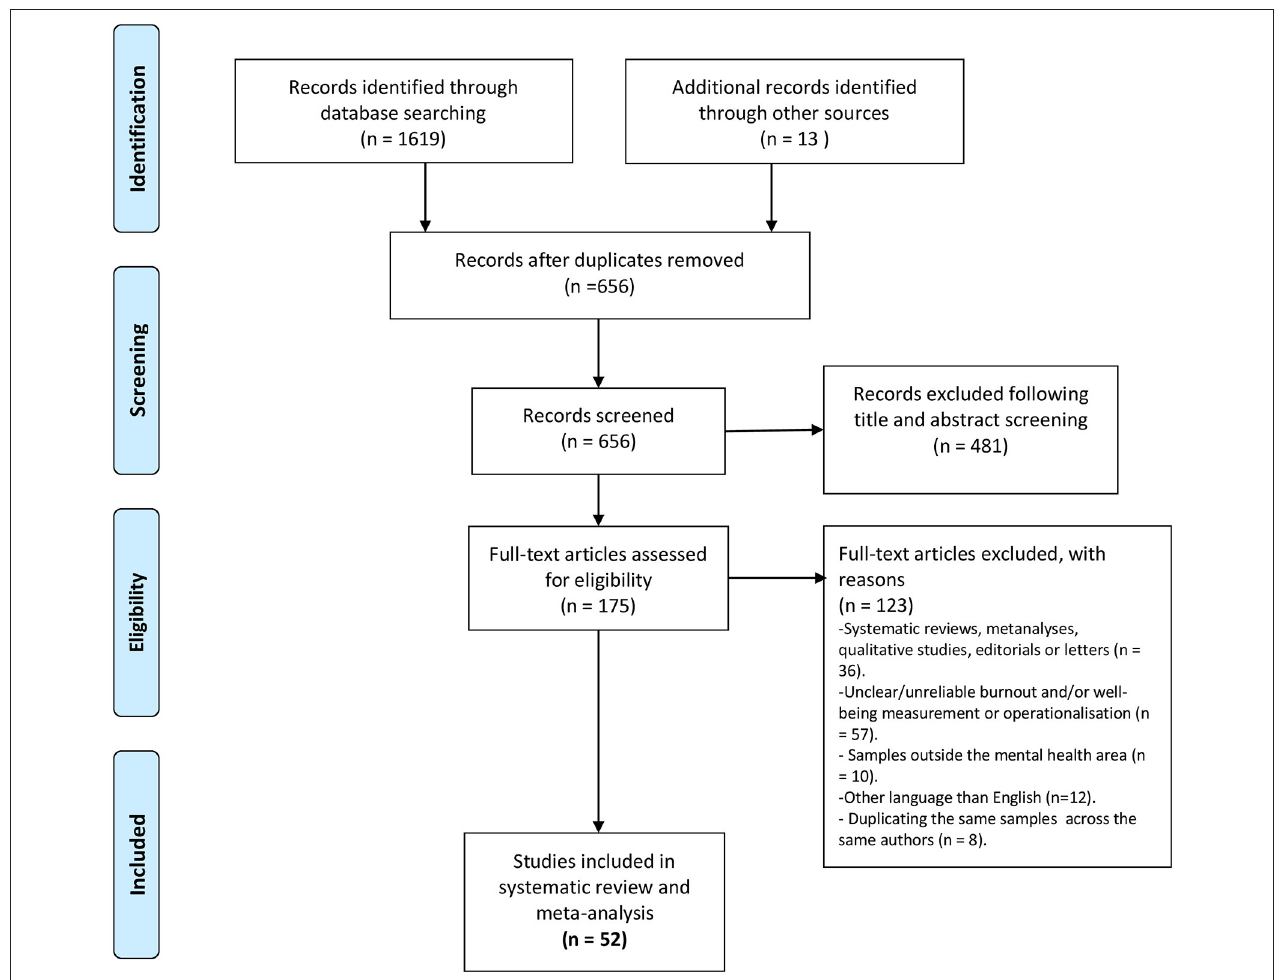
FIGURE 1 | Flow diagram. Based on: Moher et al.